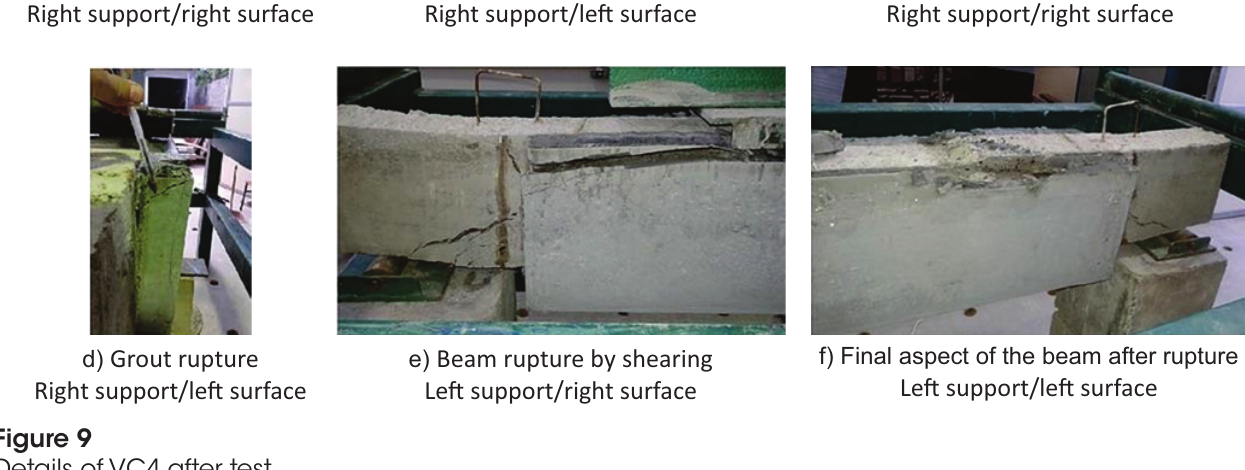
a) Grout rupture Right support/right surface